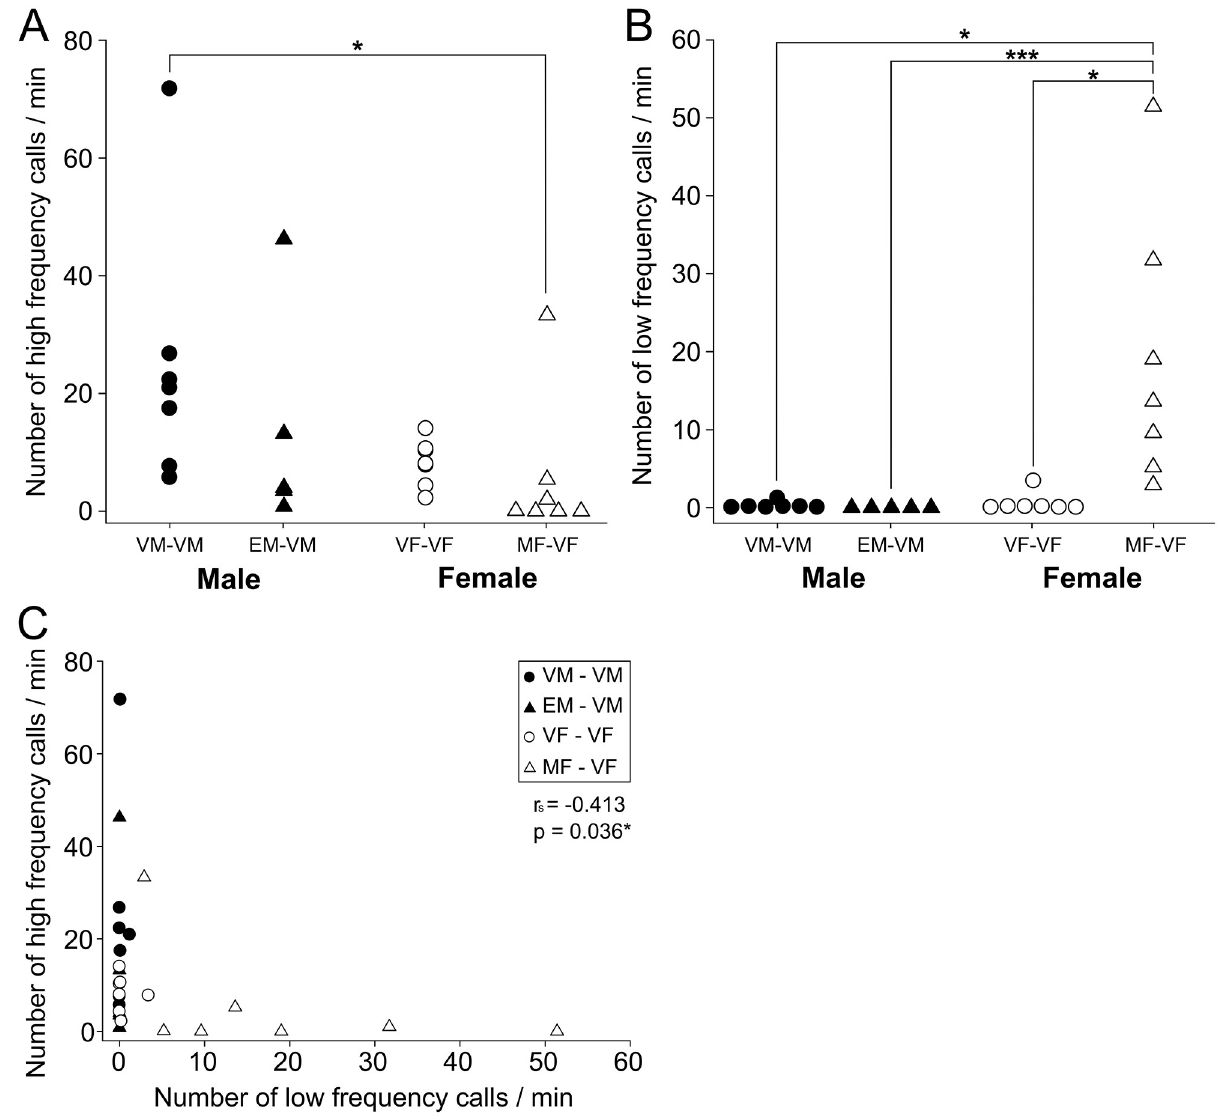
Fig 5. Numbers of two call types by during resident-intruder pairs. (A) Numbers of high-frequency calls per minute by pair-tests. VM-VM pairs emitted high-frequency calls much more than MF-VF pairs. (B) Numbers of low-frequency calls per minute by pair-tests. MF-VF pairs emitted low- frequency calls much more than the other pairs. (C) There is a negative correlation between the numbers of high-frequency calls and that of low- frequency calls (r s = -0.413; p = 0.036). Each symbol represents calls from a single test ( ● , virgin male; ▲ , experienced male; ● , virgin female; ▲ , multiparous female). � represents p < 0.05. ��� represents p < 0.001.